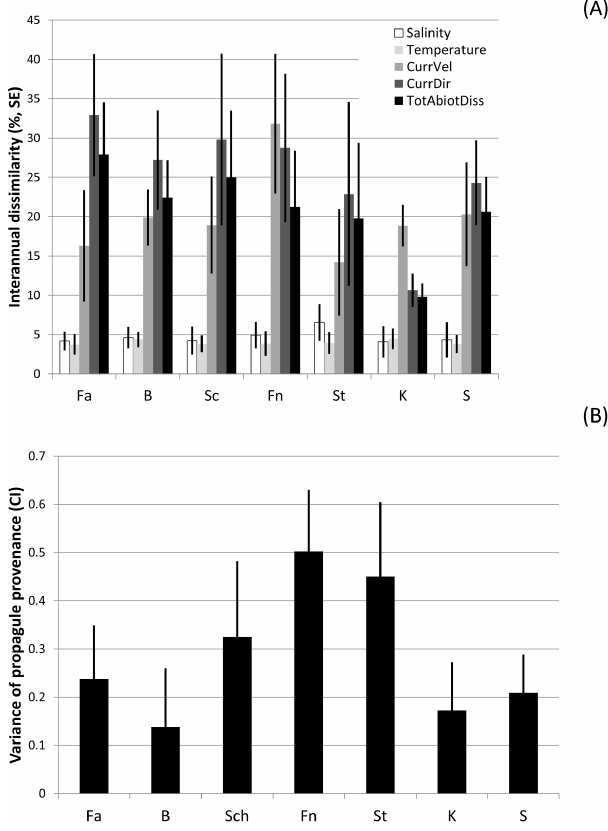
Fig. 11. (A) Mean dissimilarity between consecutive years in salinity, temperature, current velocity (CurrVel), current direc- tion (CurrDir) and of all these four variables together (TotAbiot- Diss) averaged over the months of June, July, August and over the 6yr of surveillance. (B) Variance of the propagule origin (area of the dispersal kernels of Fig.3) averaged over the 6yr of surveillance (with